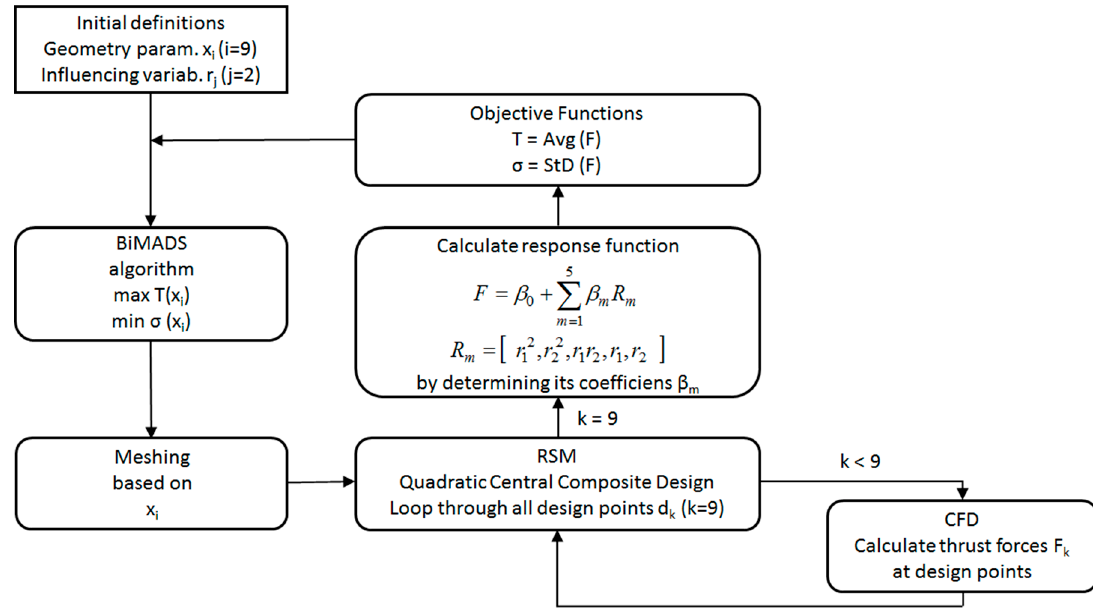
Figure 8. Detailed representation of the optimization cycle.